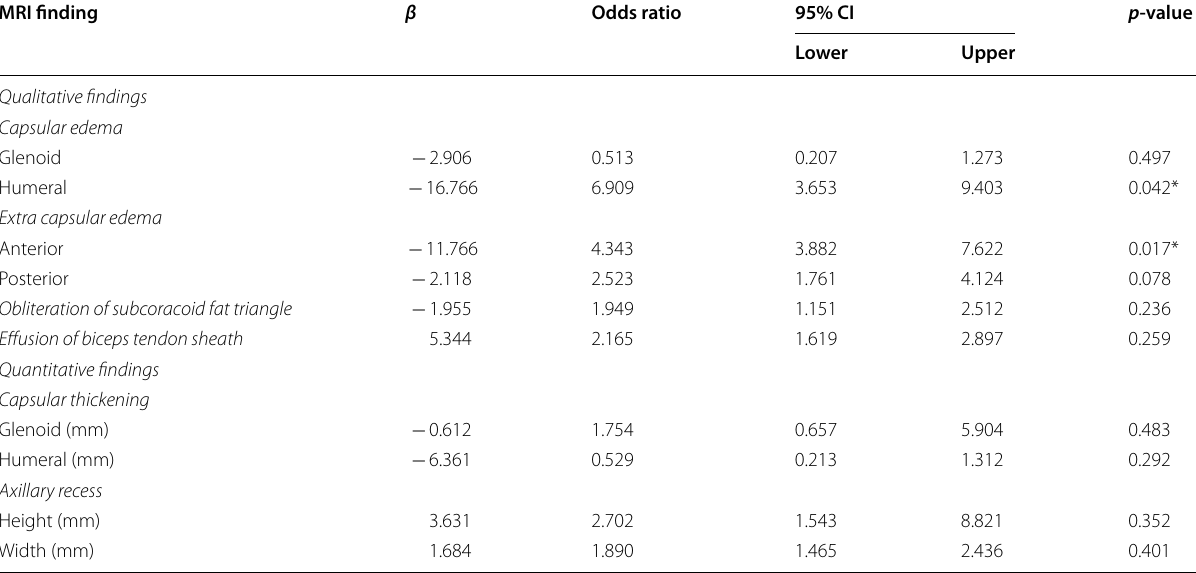
Table 11 Results of linear regression analysis to estimate variables which are most predictive of clinical impairment at limitation of ROM “external